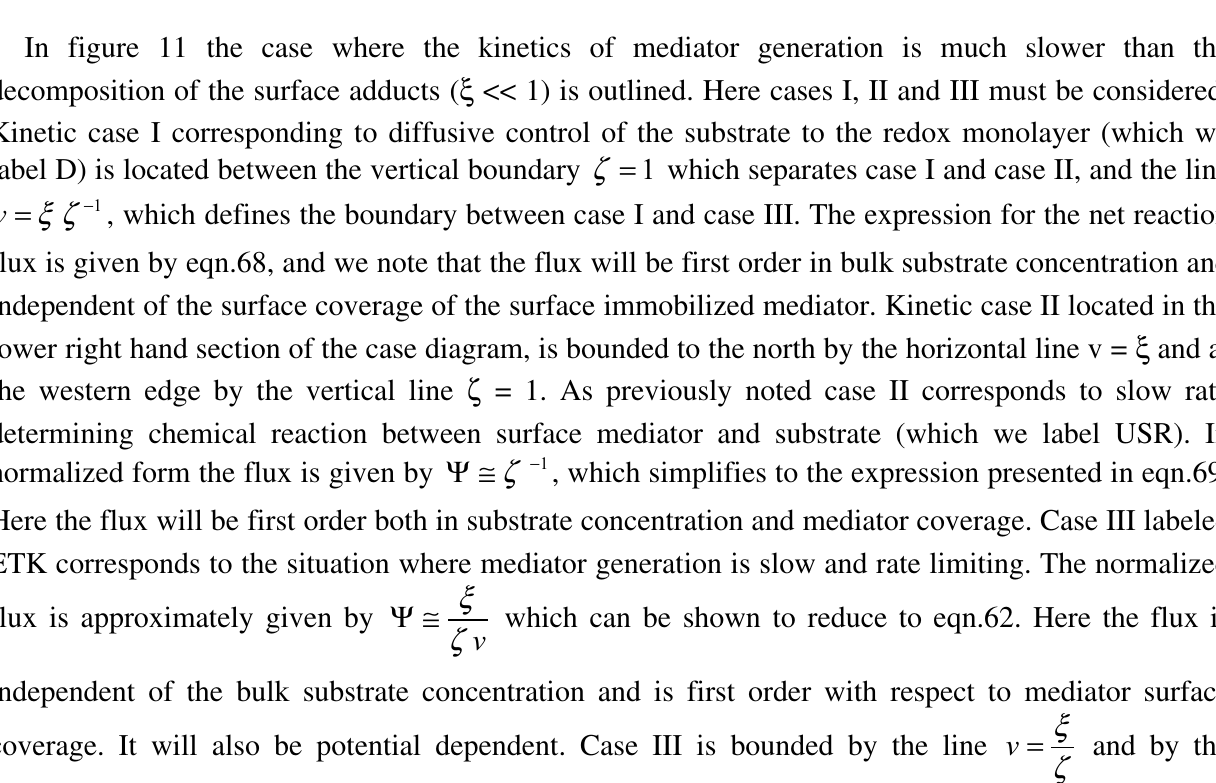
Figure 11. Kinetic case diagram for the adduct formation mechanism for the limiting case of ξ <<